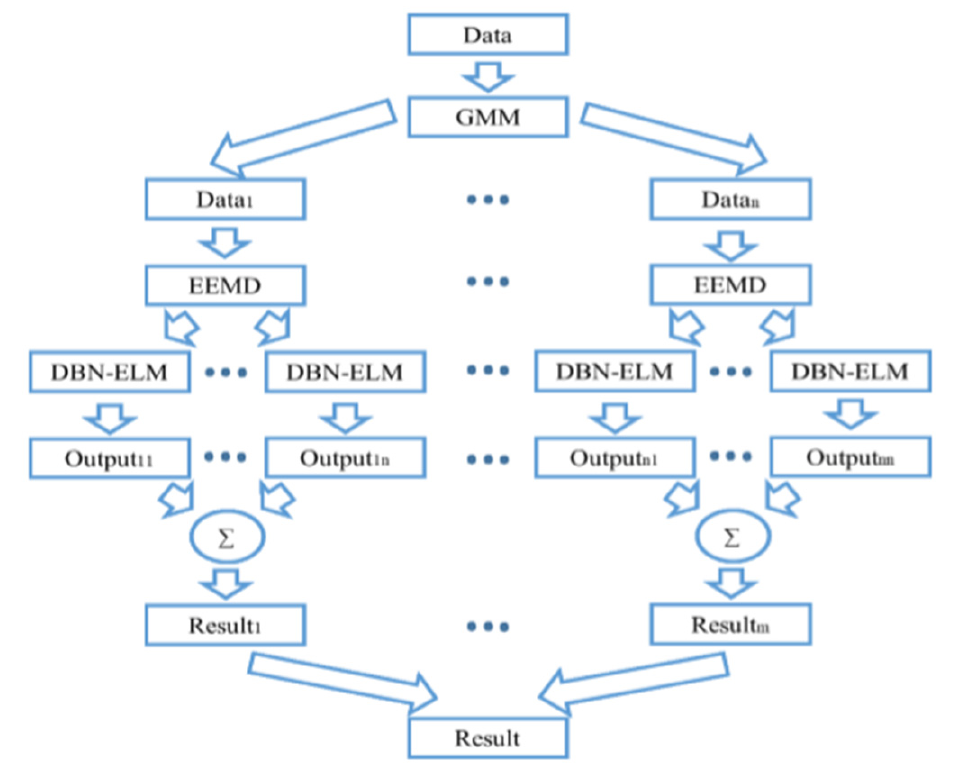
Figure 3. The flow of the improved DBN algorithm [28].